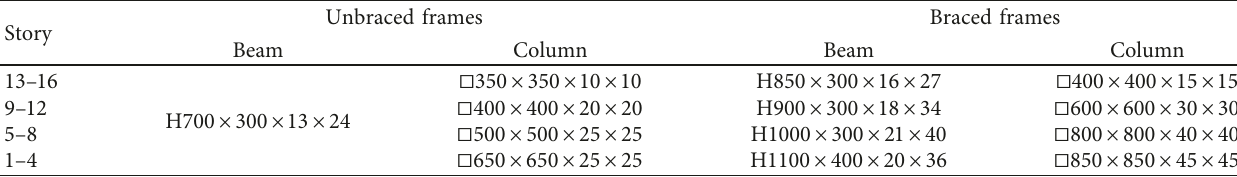
Table 4: Geometric detail of beams and columns of the 16-story frames.